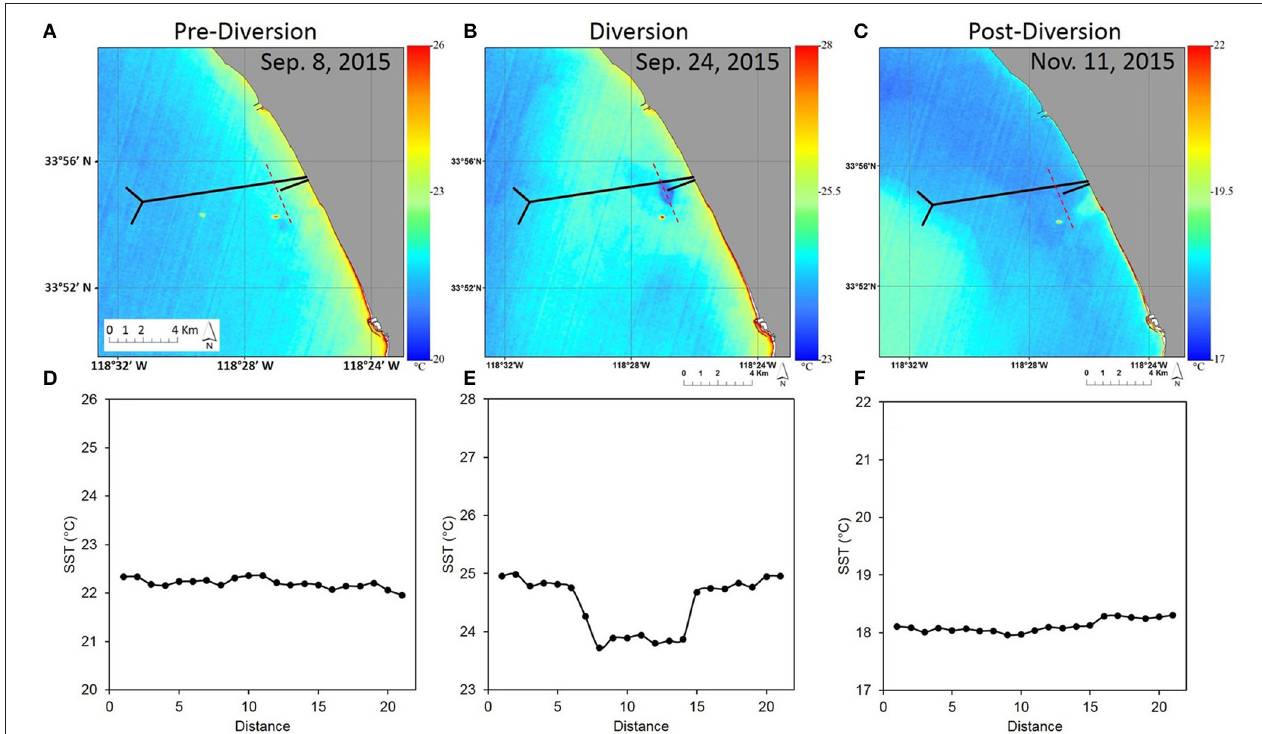
FIGURE 3 | (A–C) Landsat 8 TIRS-derived SST in Santa Monica Bay with the 5-mile and 1-mile outfall pipes shown as black lines and a 4km alongshore transect at the terminus of the 1-mile outfall pipe denoted by red dashed lines. (D–F) SSTs across the 4km alongshore transect, from north to south. (A,D ) SST on 8 September 2015, pre-diversion; (B,E) SST on 24 September 2015, during the diversion; (C,F) SST on 11 November 2015, after the diversion. Cooler SSTs were detected at the terminus of the 1-mile outfall pipe during the diversion, due to entrainment of cold bottom water as the wastewater plume surfaced. Pre- and post-diversion, no SST anomalies were observed at the terminus of the 1-mile outfall pipe. The warm signature of an oil tanker to the southwest of the 1-mile outfall pipe is clearly visible. SSTs uniformly decreased from September to November due to seasonal cooling, therefore each image is shown on different temperature